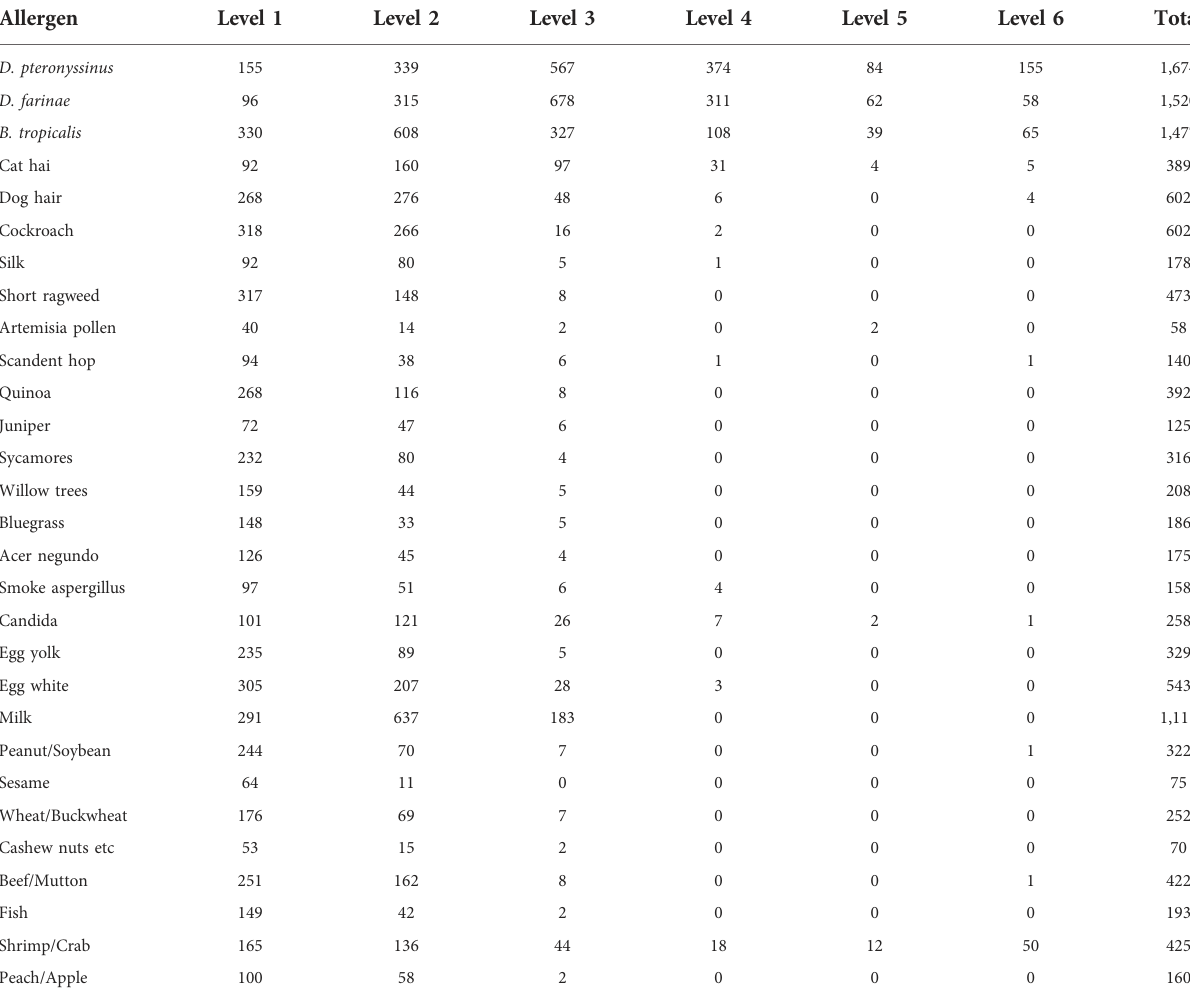
TABLE 3 Grade distribution of different inhalation and ingestive allergens in children with AR.